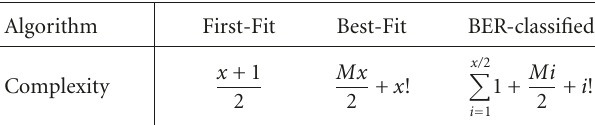
Table 1: Complexity comparison.